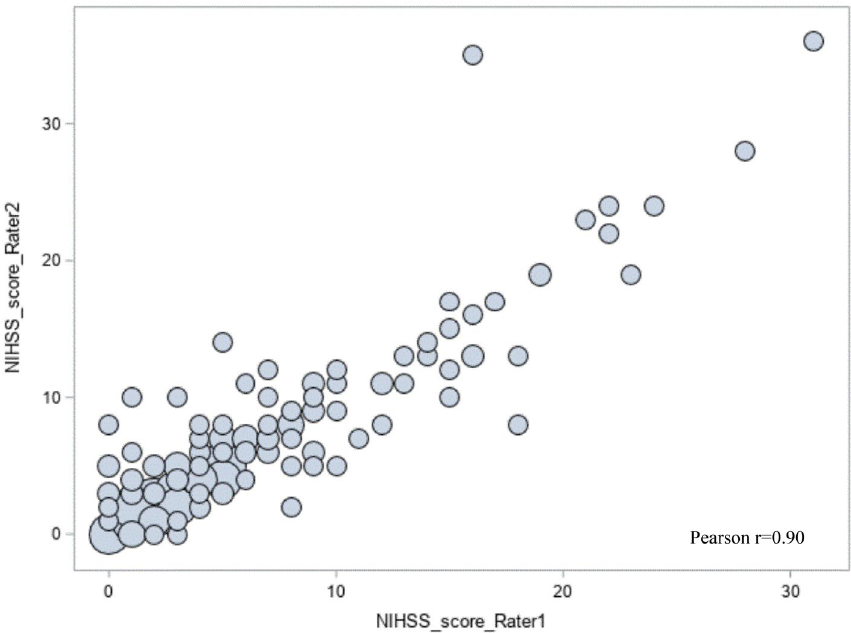
Figure 1. NIHSS score, interrater agreement, N = 180. Bubble size is proportional to the number of people with the specific NIHSS